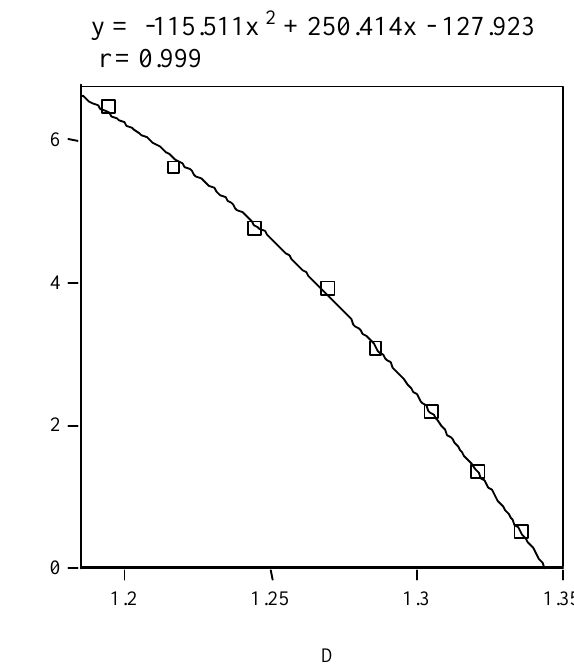
Figure 5. Hydrophile–lipophile balance of homologous phenyl alcohols vs . the fractal